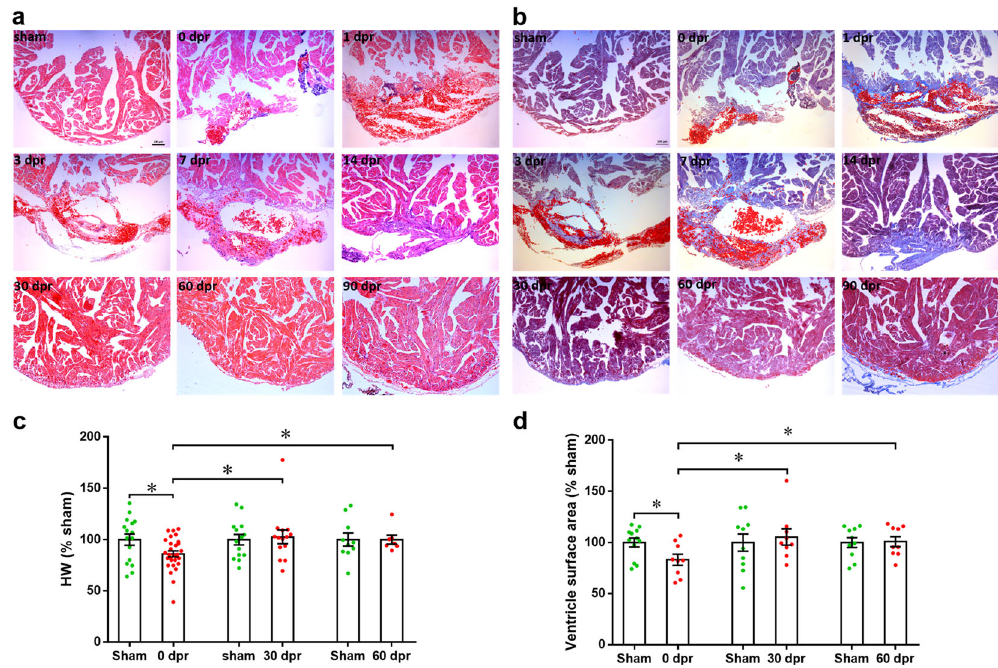
Fig. 1 Regeneration of ventricular myocardium of X. tropicalis . a Hematoxylin and eosin (H&E) staining of the frog heart before resection (sham) or at 0, 1, 3, 7, 14, 30, 60, and 90 dpr. b Masson trichrome-stained sections showing early deposition of epicardial extracellular matrix at 1 – 14 dpr, with minimal evidence of cardiac fi brosis by day 30. c , d Quanti fi cation of regeneration at 0, 30, and 60 dpr. Ventricle weights ( c ) and sagittal section surface area ( d ) are presented as percentages of sham-operated controls. Numbers of samples analyzed are indicated within the bars. Data are presented as mean ± SEM, * p < 0.05 (Student ’ s t